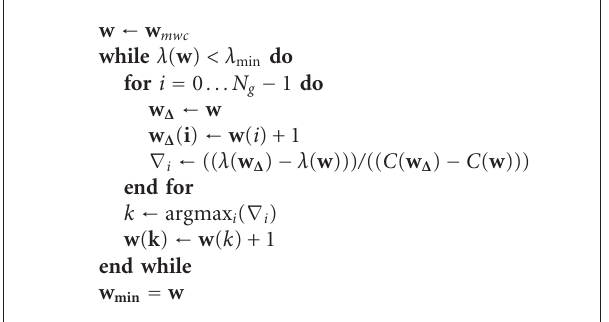
Algorithm 2: Mildest-ascent greedy algorithm for WL Optimiza-